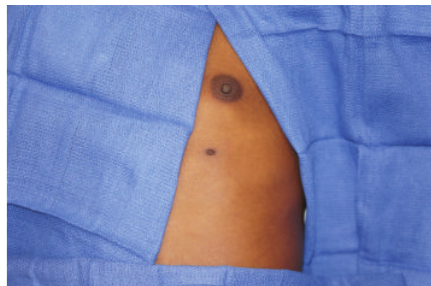
Figure 3: Accessory nipple in “milk line.”